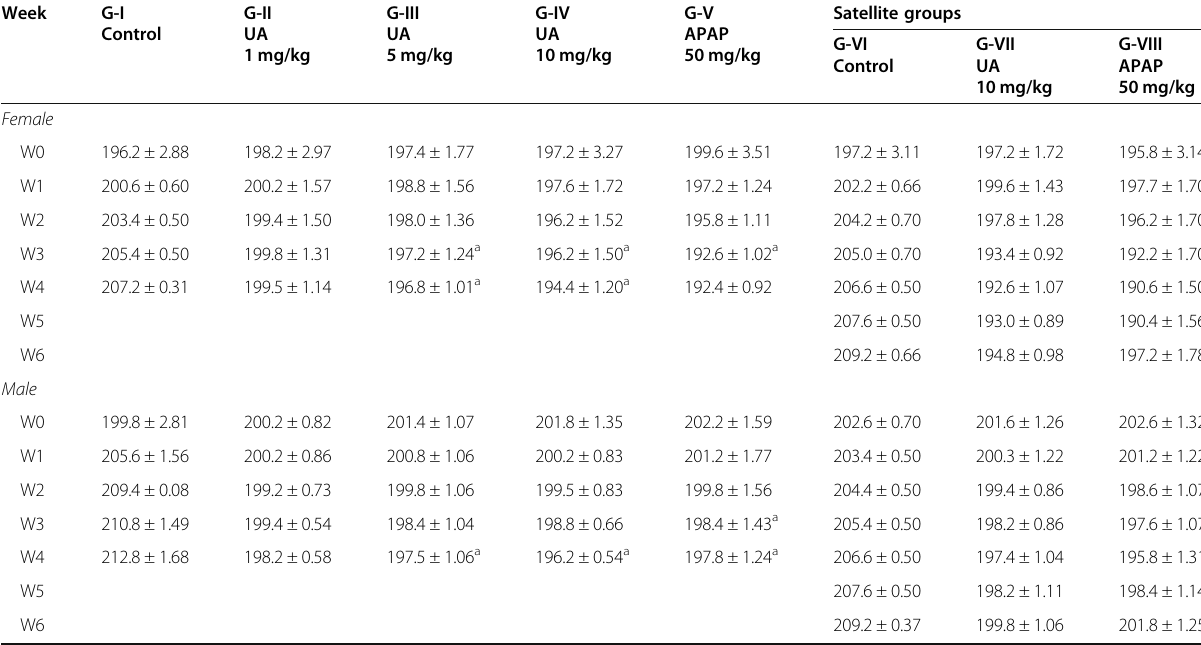
Table 2 Effects of sub-acute oral administration of UA and APAP on body weight (g) of Wistar rats ( n =